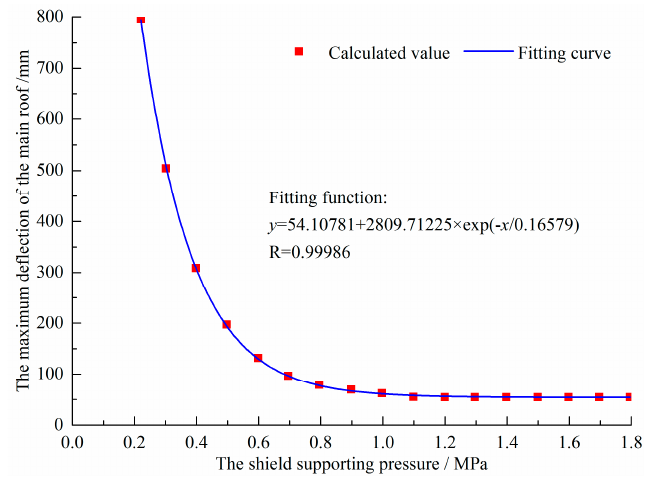
Figure 6. Relationship between the maximum deflection and the shield supporting pressure.